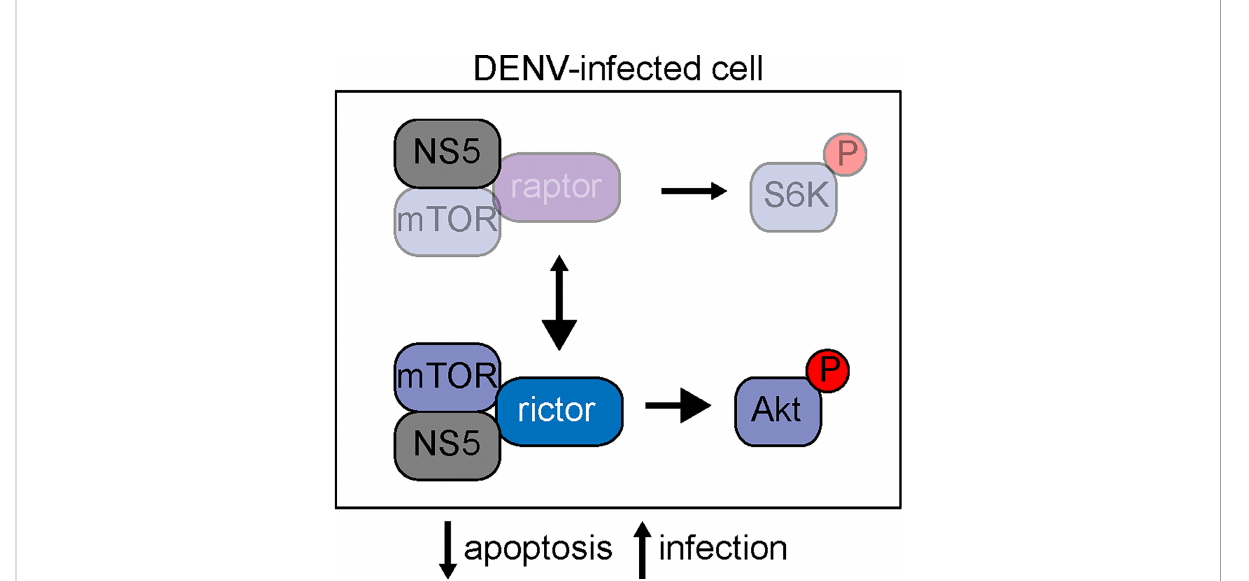
FIGURE 5 Schematic of mTOR signaling in dengue infection. At resting state, mTOR can participate in two well-characterized complexes, mTORC1 and mTORC2. mTORC1 is characterized by the binding of mTOR to raptor, whereas mTORC2 requires mTOR binding to rictor. Our data is consistent with a model where NS5 binds mTOR, and this binding stabilizes the mTORC2 complex, leading to elevated signaling through phosphorylated Akt and subsequent protection against cellular apoptosis to support viral